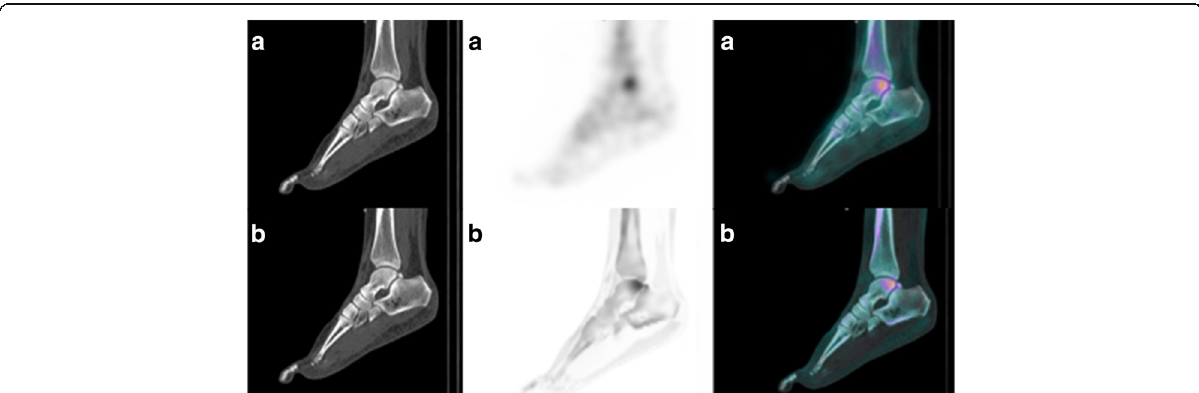
Fig. 5 Example of a better location of a pathological uptake with xSPECT Bone® reconstruction. This SPECT/CT was performed in order to explore a chronic right ankle pain which appeared 1 year ago without traumatism. An uptake of the talus is observed on the F3D image ( a ) whereas an uptake of the talus and of a trigonum bone is observed on the xB image ( b ). MRI realized after SPECT/CT did not show contusion of the talus but confirmed the right os trigonum syndrome observed on xB